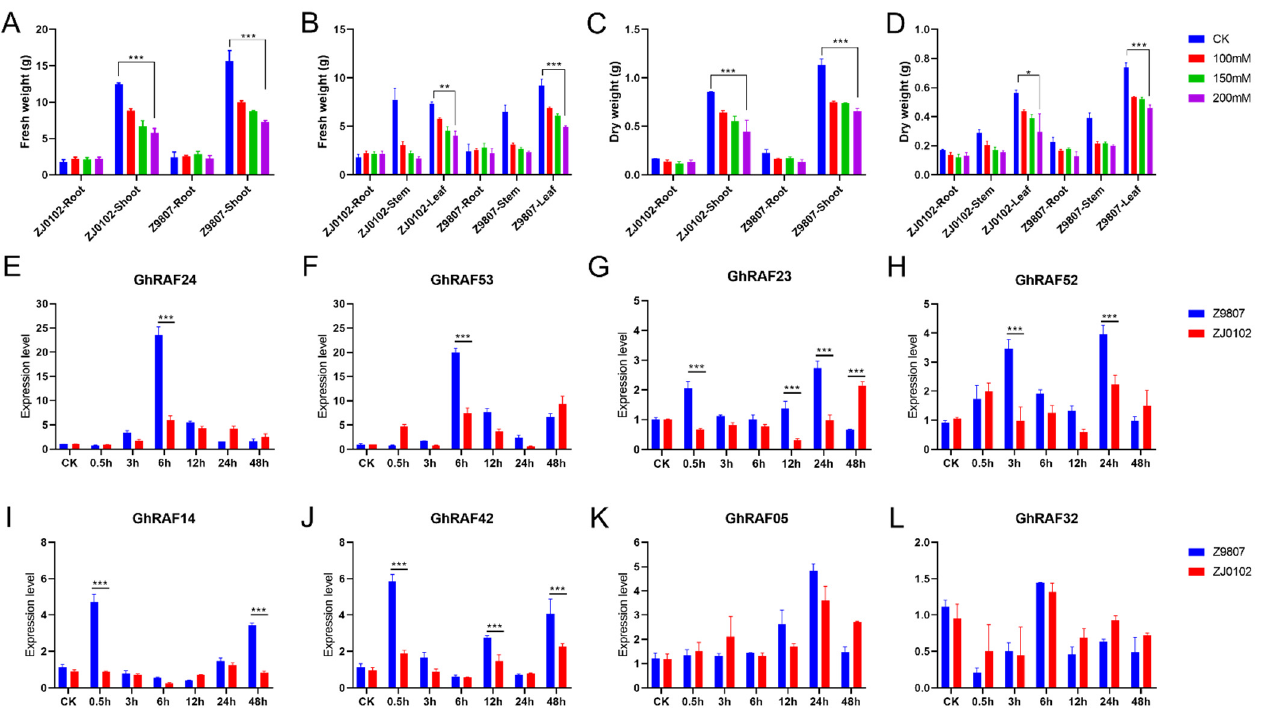
Figure 5. Evaluation of different salt stress treatments on root shoot weight for RT-qPCR and expression analysis of candidate genes ( A ) Fresh weight of root and shoot ( B ) Fresh weight of root, stem and leaf ( C ) Dry weight of root and shoot ( D ) Dry weight of root, stem and leaf. Expression analysis of GhRAF24 ( E ); GhRAF53 ( F ); GhRAF23 ( G ); GhRAF52 ( H ); GhRAF14 ( I ); GhRAF42 ( J ); GhRAF05 ( K ); GhRAF32 ( L ). CK means NaCl-untreated as control.0.5–48 h means different time points after NaCl stress. The significant difference is Student ’s t test; * p < 0.05; ** p < 0.01; *** p < 0.001.